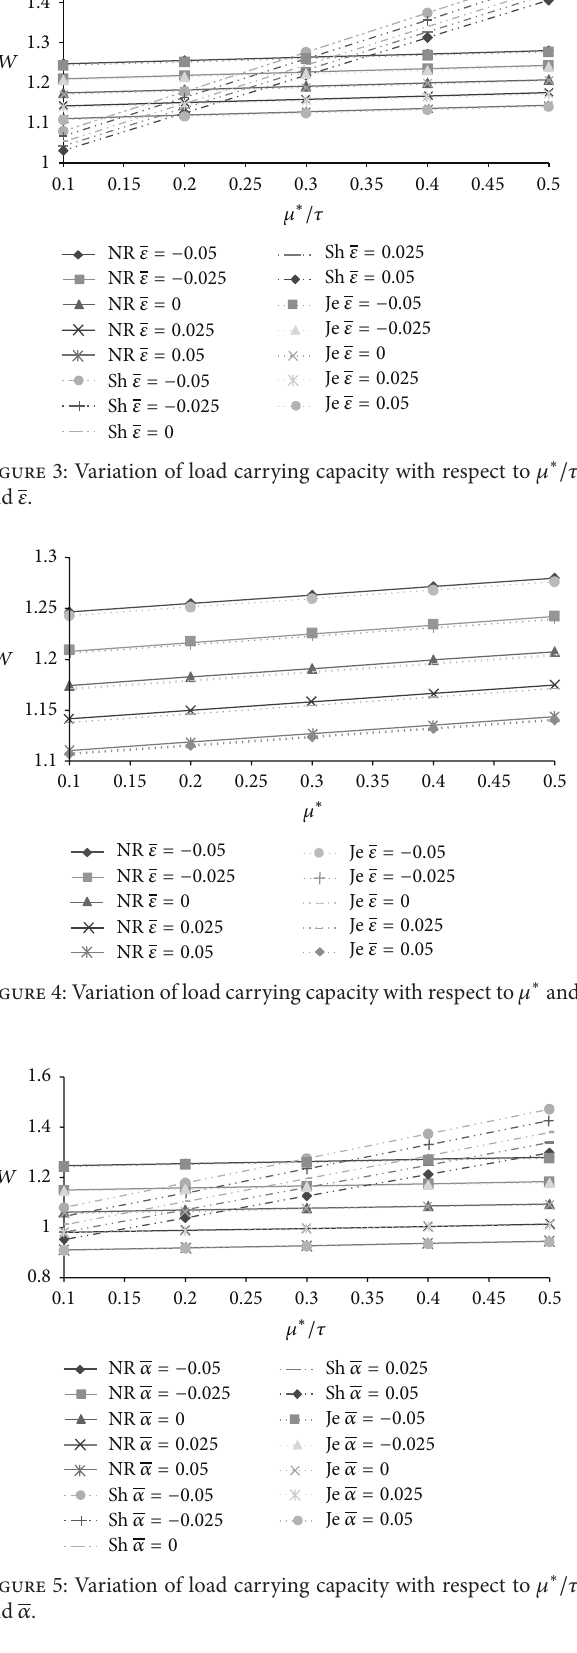
Table 1: Variation of load carrying capacity with respect to 𝜇 ∗ /𝜏 and 𝜎 .